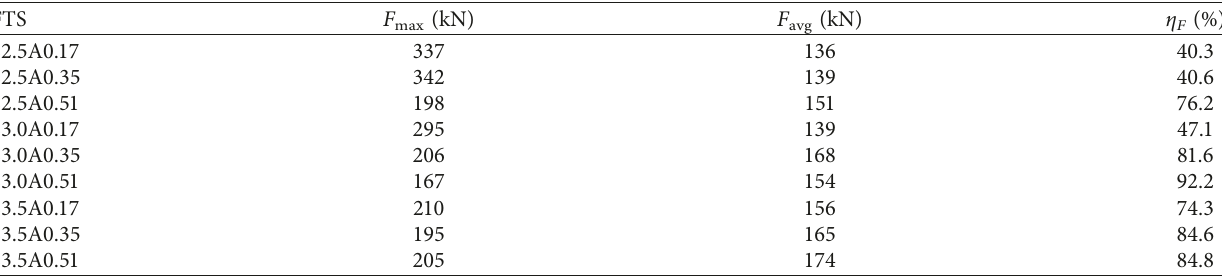
Table 8: Loading efficiency of